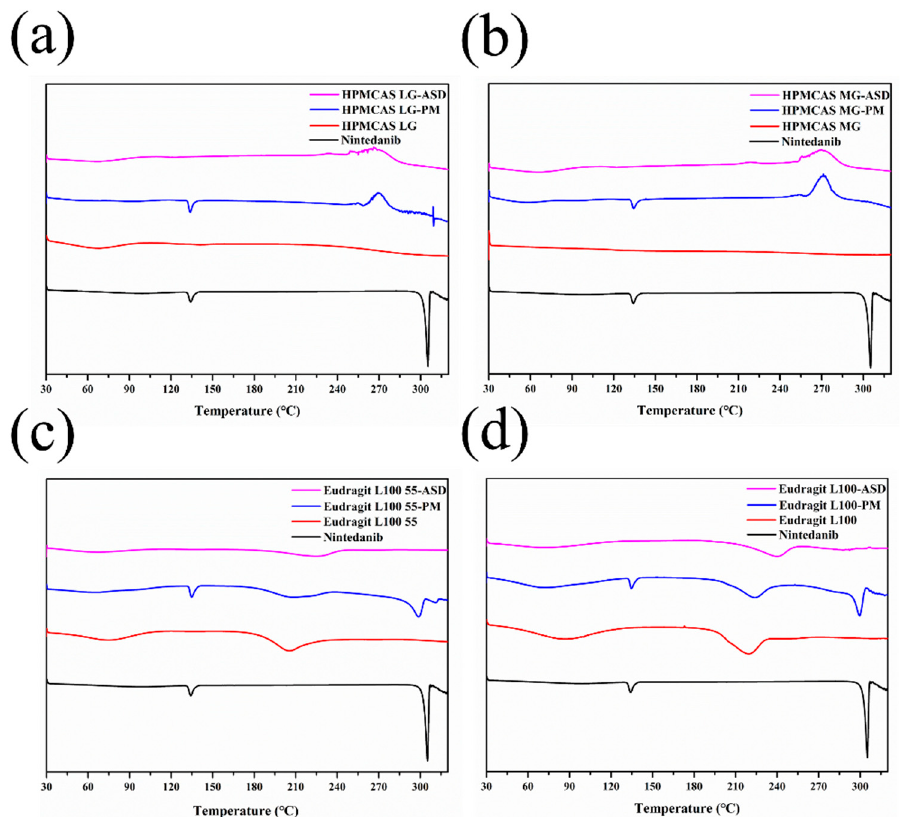
Figure 8. DSC curves of nintedanib and samples with ( a ) HPMCAS LG, ( b ) HPMCAS MG, ( c ) Eudragit L100 55, ( d ) Eudragit L100.